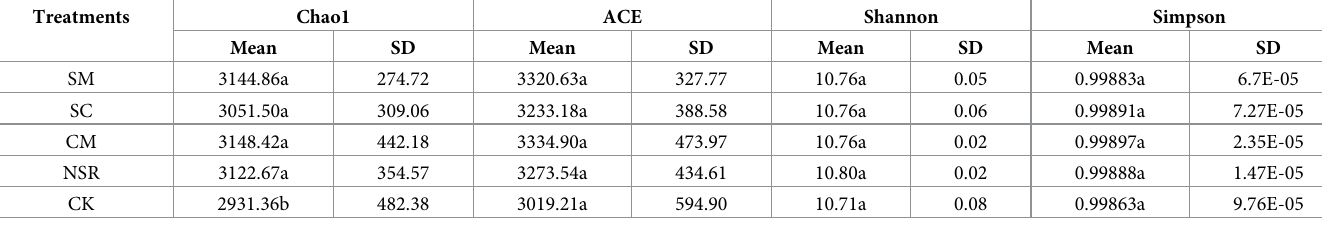
Table 3. Richness and alpha-diversity indices of the different OTUs under the different treatments.